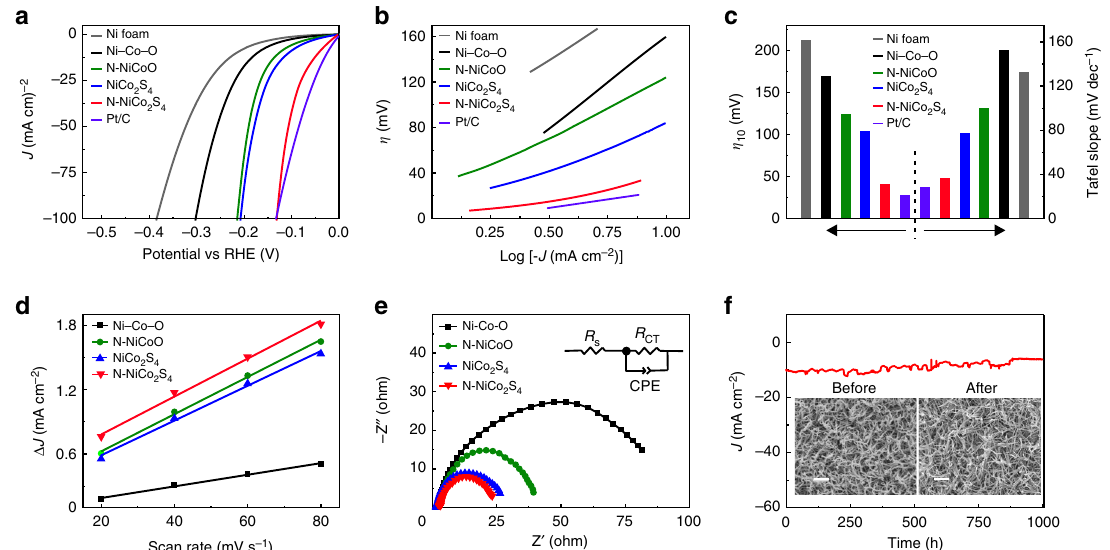
Fig. 4 Electrochemical HER performance. a LSV curves with a scan rate of 5 mV s − 1 in 1.0 M KOH solution, b Tafel plots, and c the comparison of overpotential at 10 mA cm − 2 and Tafel slopes, for the bare Ni foam, Ni – Co – O, N – NiCoO, NiCo 2 S 4 , N – NiCo 2 S 4 and Pt/C, respectively. d The plots of Δ J versus scan rates for the Ni – Co – O, N – NiCoO, NiCo 2 S 4 , and N – NiCo 2 S 4 , respectively. e Nyquist plots of the Ni – Co – O, N – NiCoO, NiCo 2 S 4 and N – NiCo 2 S 4 at 50 mV vs. RHE. The inset is the equivalent circuit model that contains the electrolyte resistance ( R s ), constant phase element (CPE) and charge-transfer resistance ( R CT ). f Current density versus time ( i – t ) curves of N – NiCo 2 S 4 NWs recorded for 1000 h at 50 mV vs. RHE, without IR correction. The SEM images for N – NiCo 2 S 4 before and after stability test are illustrated as the insets; the scale bar is 1 μ